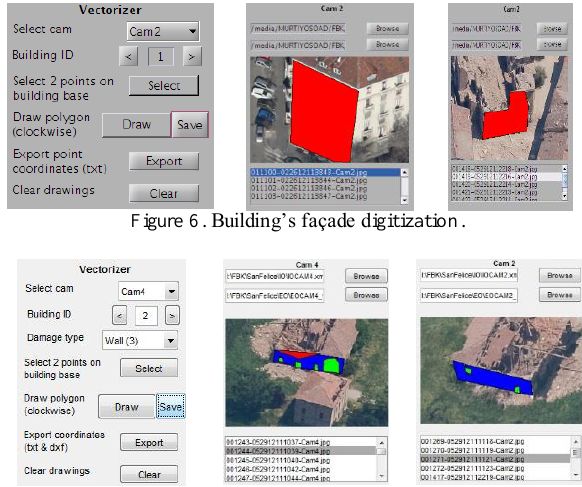
Figure 7. Digitization of building elements (wall, roof, window, etc.), assigning semantic information (and different colors) useful for damage